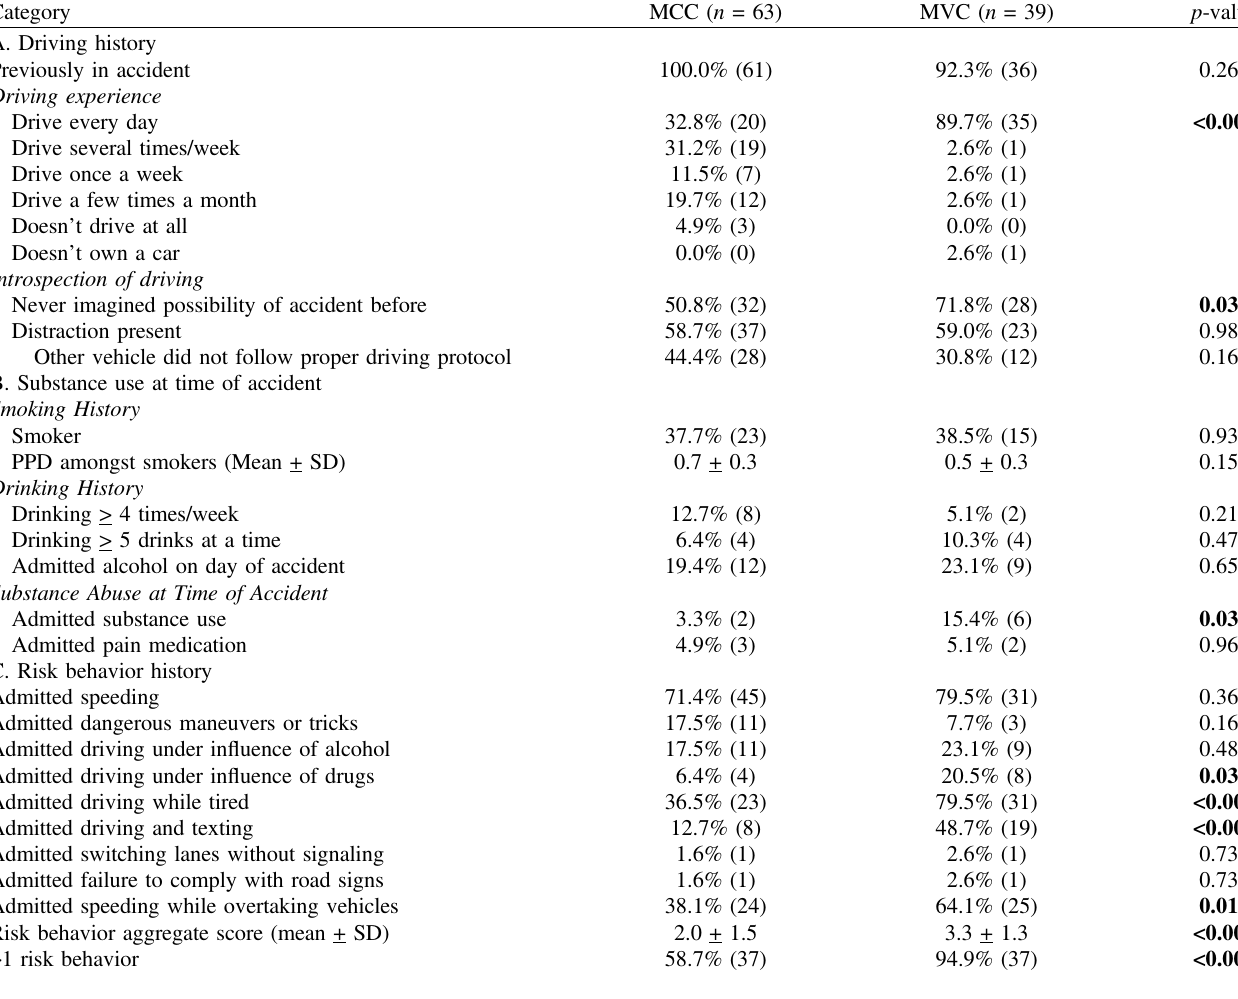
Table 3. Patient risk behaviors.